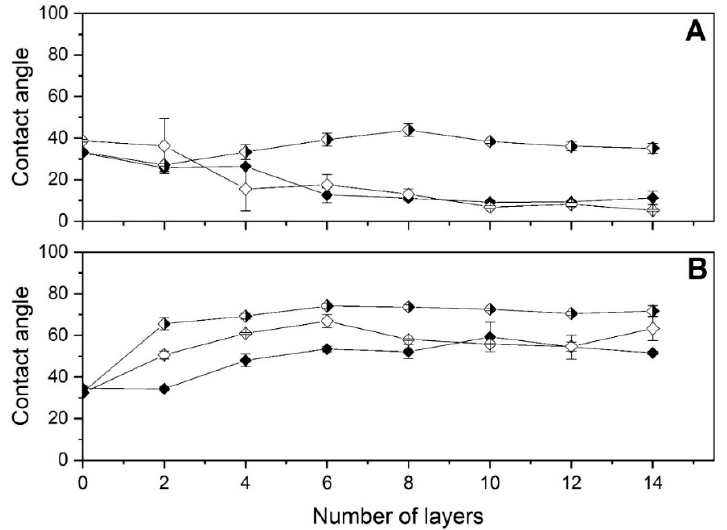
Figure 3. Water contact angle of PEMs with negatively charged topmost layer composed of AH ( A ) and AAm ( B ) alternately deposited with C1H (black diamonds), C2H (white diamonds), or CAm (black and white diamonds).